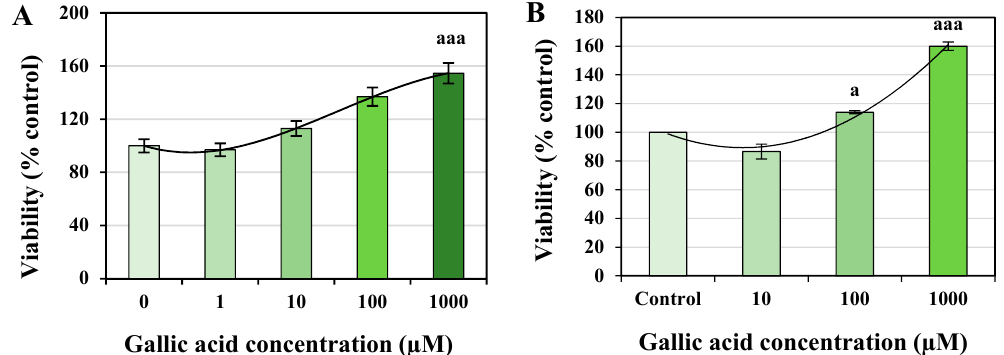
Figure 1. Effect of different concentrations of gallic acid (GA) on the viability of rat’s embryonic fibroblast (REF) ( A ) and pancreatic islet cells ( B ). The MTT assay was performed after 24 h of exposure to determine the EC 50 of GA. The EC 50 of GA on REF and pancreatic islet cells was calculated as 554.25 and 400 μ M, respectively. Data are presented as the mean ± standard error of measurements performed on six groups, with three independent replicates; a p < 0.05; aaa p < 0.001.